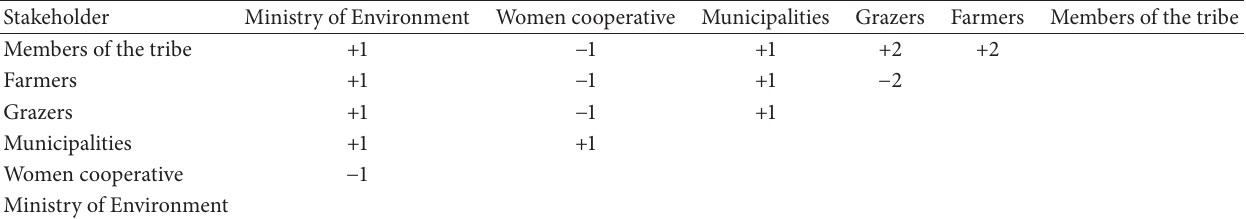
Table 2: Stakeholders’ communication